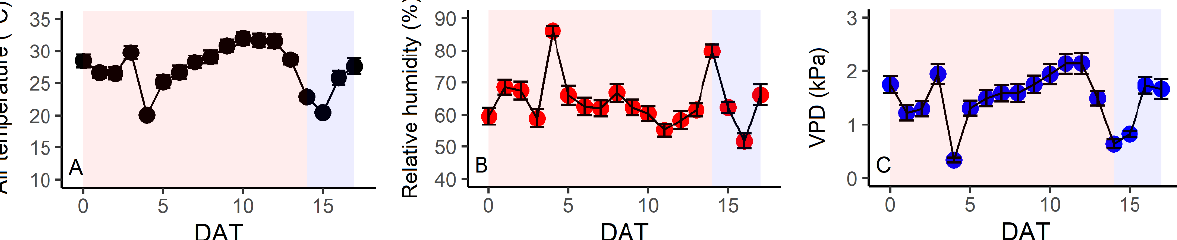
Figure 1. Average daily environmental conditions during the experimental period (21 July 2020 until 7 August 2020) Red background in the graphs represent stress application to WS pots while blue background represent the recovery period. ( A ) Average air temperature, ( B ) average relative humidity and ( C ) average vapor pressure deficit (VPD). Values are means ± standard error of the means.